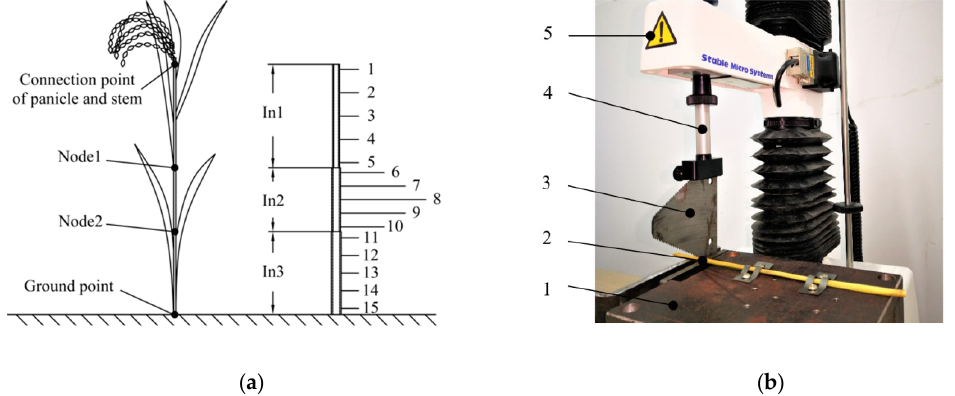
Figure 5. ( a ) Rice stalk division and numbering; ( b ) shearing test rig. (1) Placement platform, (2) stalk, (3) blade, (4) blade holder, (5) texture analyzer